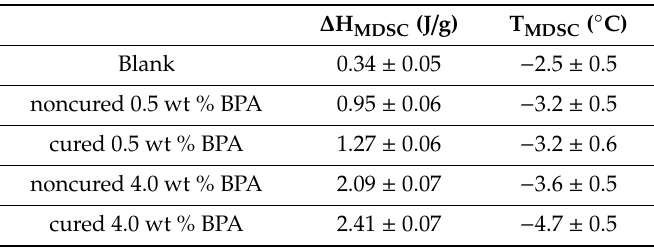
Table 2. Energy associated with the endothermic fourth event, Δ H MDSC , and characteristic temperature of the second event (T MDSC ) obtained by MDSC for selected binders.